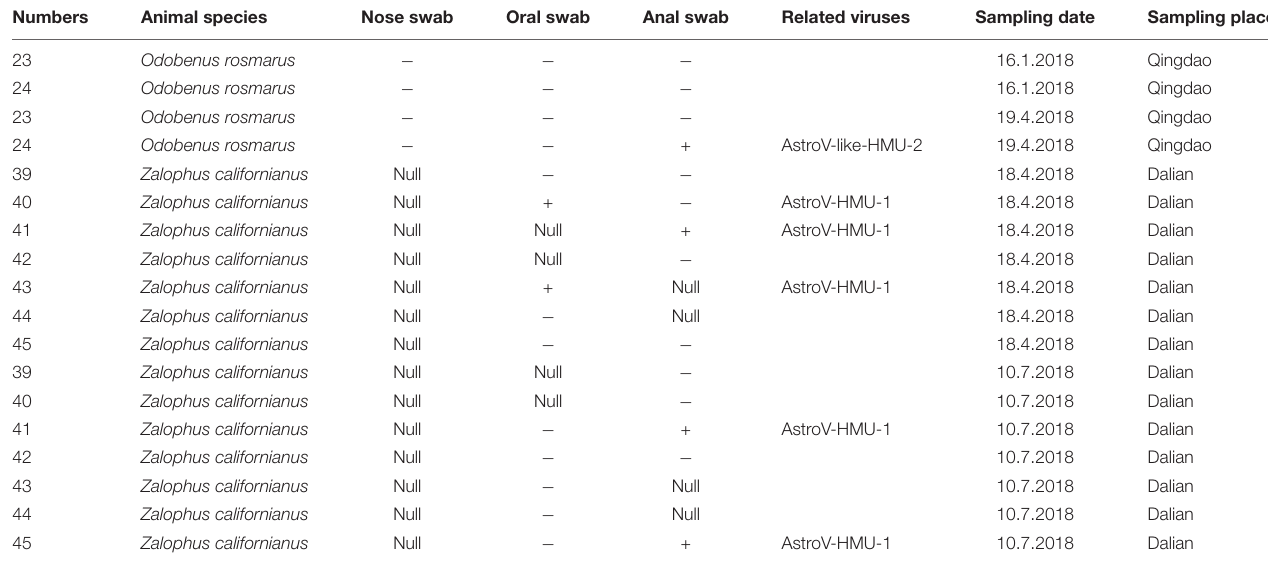
Animal species Nose swab Oral swab Anal swab Related